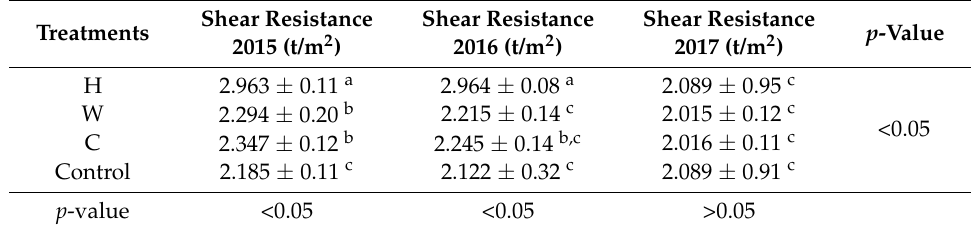
Different letters show significant differences among values in a column (Tukey